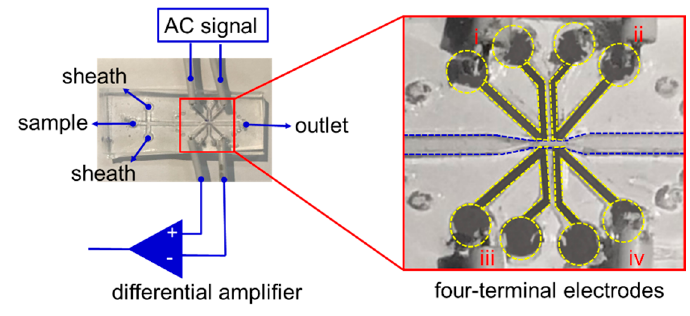
Figure 4. The microfluidic device used in the experiments for particle counting applications.